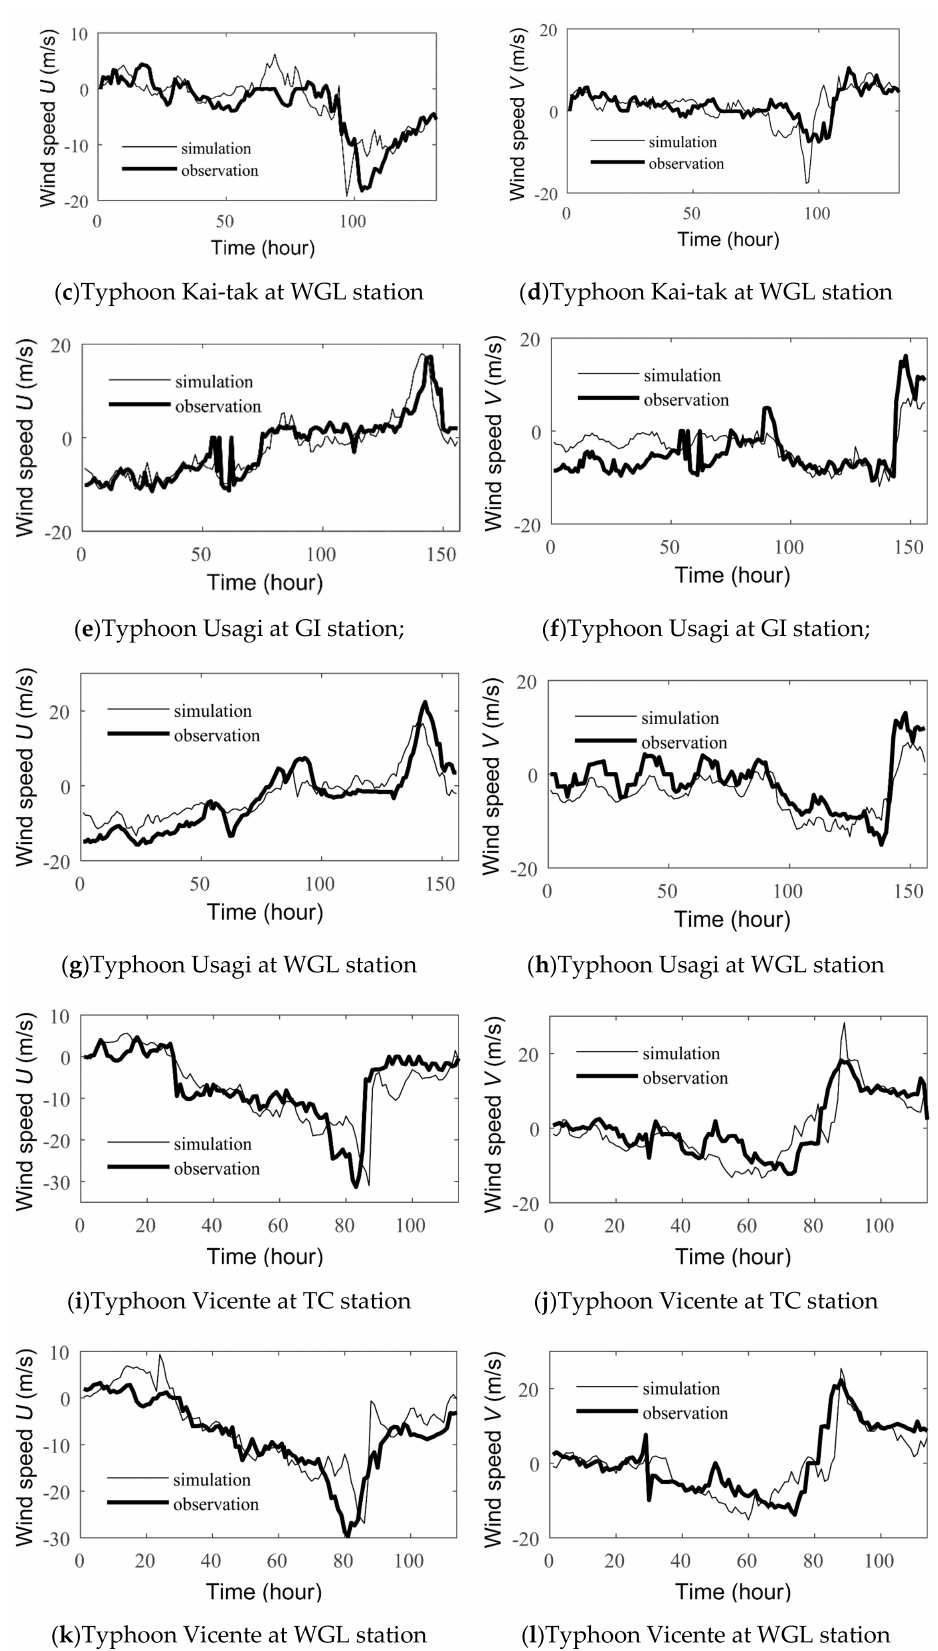
Figure 4. The west–east (U) and north–south (V) wind velocities simulated/measured at the land weather station, ( a – d ) Typhoon Kai-tak; ( e – h ) Typhoon Usagi; ( i – l ) Typhoon